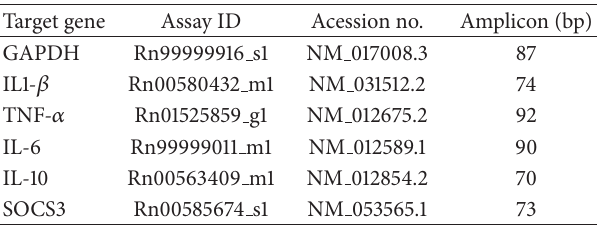
Table 1: Inventoried TaqMan Primers and probe (TaqMan Gene Expression Assays, Applied